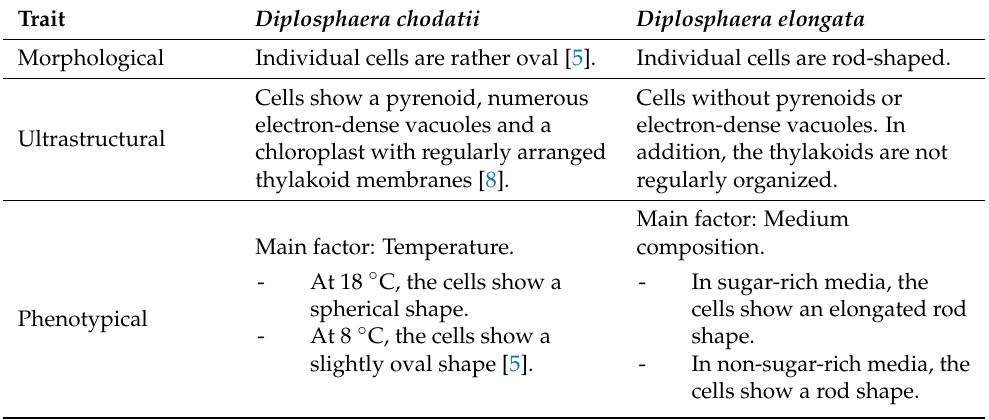
Cells without pyrenoids or electron-dense vacuoles. In addition, the thylakoids are not regularly organized. Main factor: Medium composition. - In sugar-rich media, the cells show an elongated rod shape. - In non-sugar-rich media, the cells show a rod